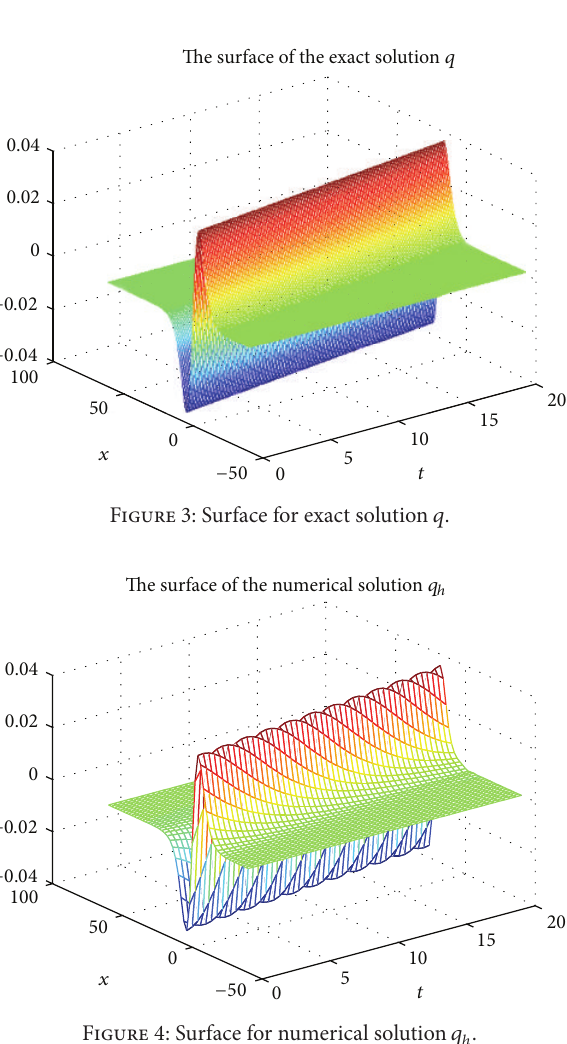
Figure 2: Surface for numerical solution 𝑢 ℎ .